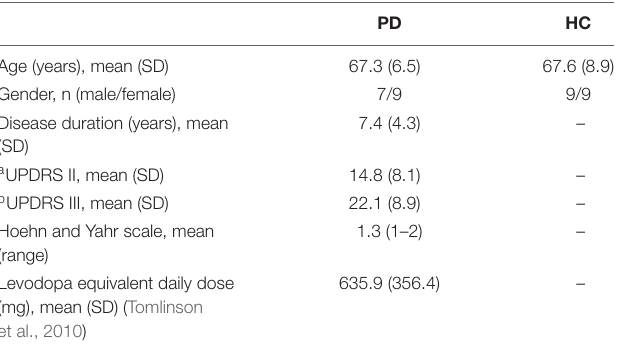
TABLE 1 | Demographic and clinical characteristics of the patients with Parkinson’s disease (PD) and healthy controls